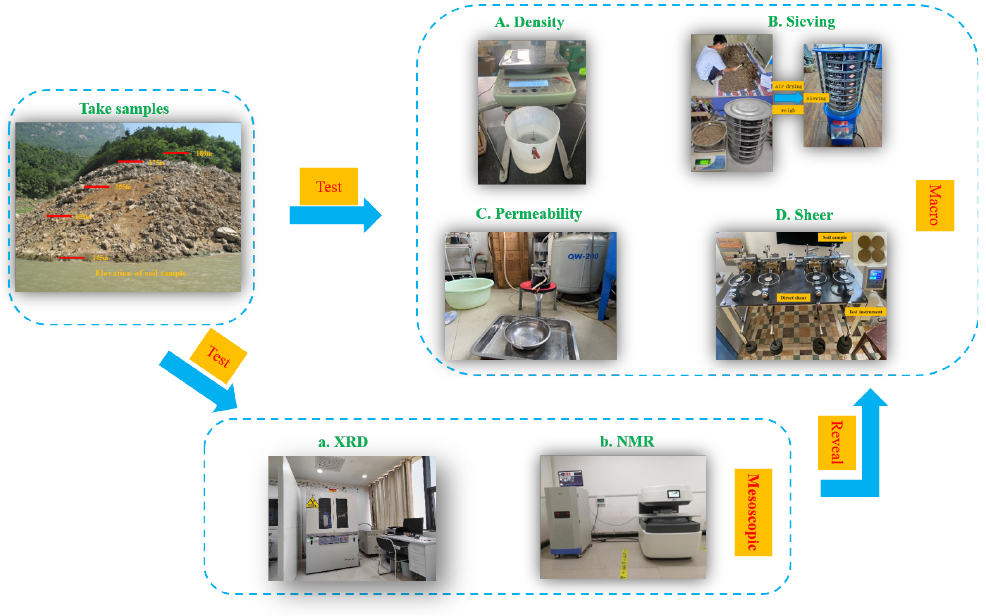
Figure 2. Test process